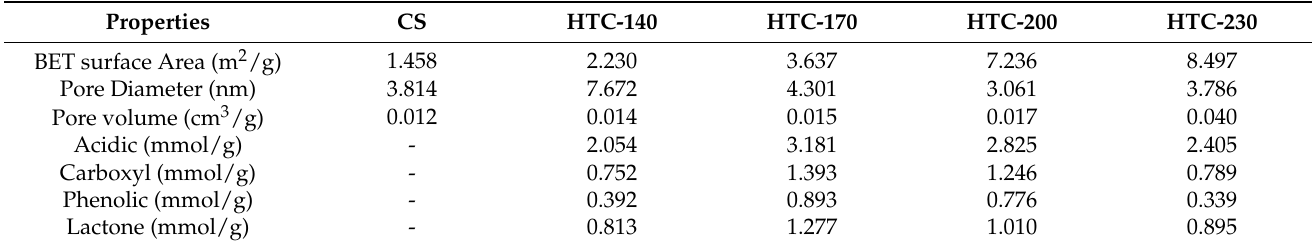
Figure 6. N 2 adsorption-desorption isotherms ( a ) and pore size distributions ( b ) of CS and hydrochar. Table 2. Summary of properties for CS and